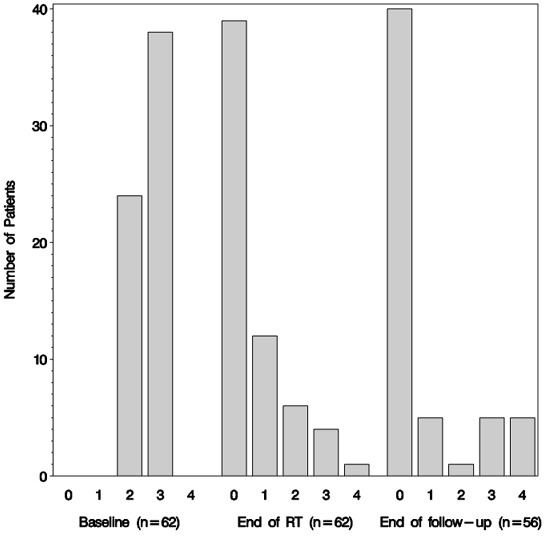
Bar chart showing the proportion of patients with WHO bleeding grade 0–4 before hemostatic radiotherapy, at the end of radiotherapy and at the end of follow-up.